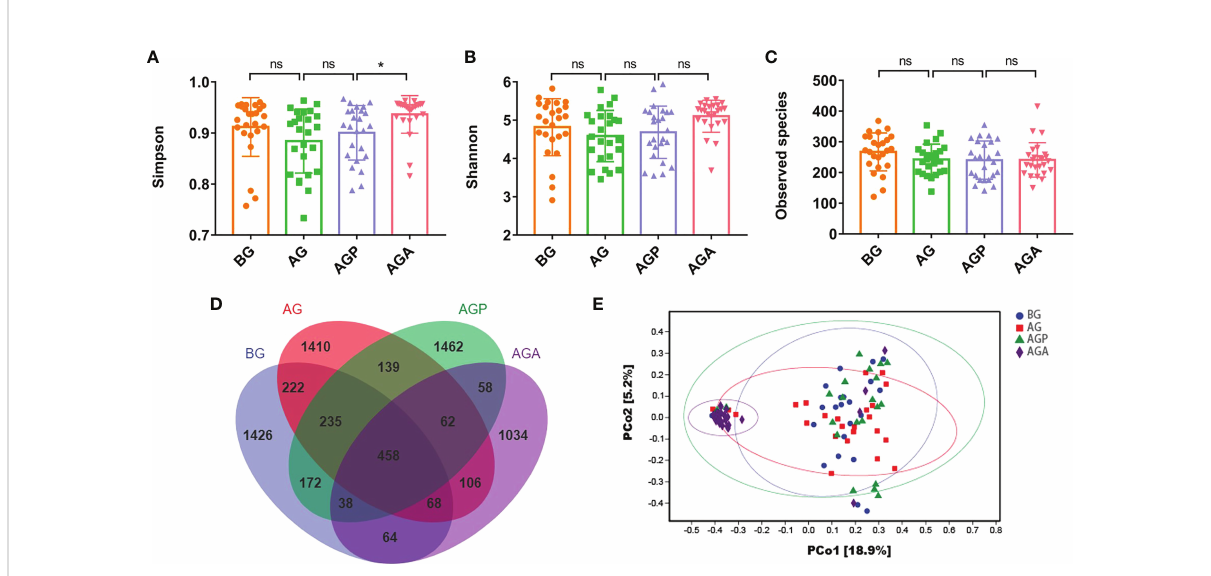
FIGURE 4 C butyricum altered gut microbial diversity in patients with gastric cancer after gastrectomy. (A) Simpson index; (B) Shannon index; (C) Observed species; (D) scalar-Venn representation; (E) PCoA of b -diversity index. BG, gastric cancer patients before gastrectomy (n=25); AG, gastric cancer patients after gastrectomy (n=25); AGP, gastric cancer patients and treatment with the placebo after gastrectomy (n=45); AGA, gastric cancer patients and treatment with the C butyricum after gastrectomy (n=47). Data are presented as means ± SD. ns, no signi fi cance, P > 0.05, * P < 0.05.